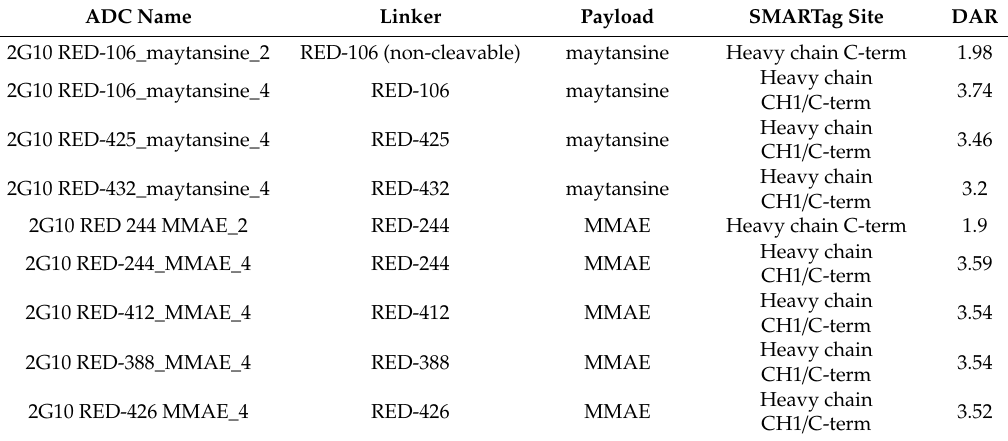
Figure 1. 2G10 binding to recombinant and cell surface urokinase receptor (uPAR). ( a ) Cell surface levels of uPAR were measured using a goat derived anti-human uPAR antibody that was detected with a secondary anti-goat antibody by immunofluorescent staining and flow cytometry. uPAR levels are represented detected on the surface of TNBC cell lines MDA-MB-231 (cyan), MCF7 (ER+ /PR+, orange), SKRB3 (ER-/PR-/HER2+, light green), HCC1569 (ER-/PR-/HER2+, brown), HMEC (dark green). All cell lines were stained with an anti-goat secondary antibody. The non-specific binding of the secondary antibody control is shown in red. Representative curves from three runs are shown. Standard deviation of peaks are: MDA-MB-231, ±170; HCC1569, ±42.8; SKRB3, ±35.6; MCF7, ±17.9; HMEC, ±15.6. ( b ) Western blot of reduced and non-reduced uPAR following SDS-PAGE. White arrow indicates uPAR location on gel. Left: Coomassie-stained, center: blotted with polyclonal anti-uPAR, right: gels were blotted with 2G10 Fab on a rabbit IgG scaffold and probed with a secondary anti-rabbit conjugated to horseradish peroxidase (HRP). L indicates sizing ladder, NR indicates non-reducing conditions, R indicates reducing conditions. ( c ) Representative nsEM 2D class averages of monomeric uPAR and uPAR-2G10 Fab complexes. Box size for the 2D class averages is 201 Å. Table 1. Antibody-drug conjugate (ADC)